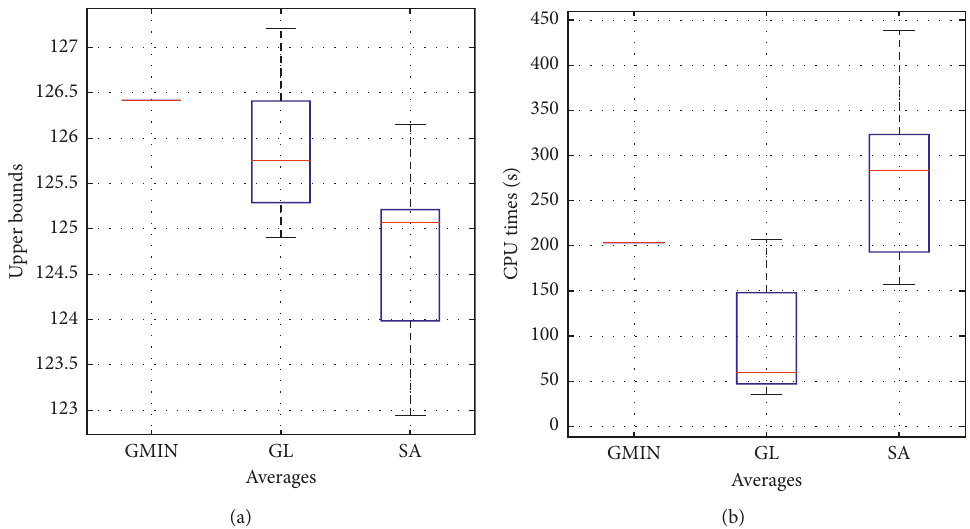
Figure 10: (a) Average upper bounds and (b) CPU times in seconds for the instance #10 in Table 9 while using a radial coverage value of 0.2km.